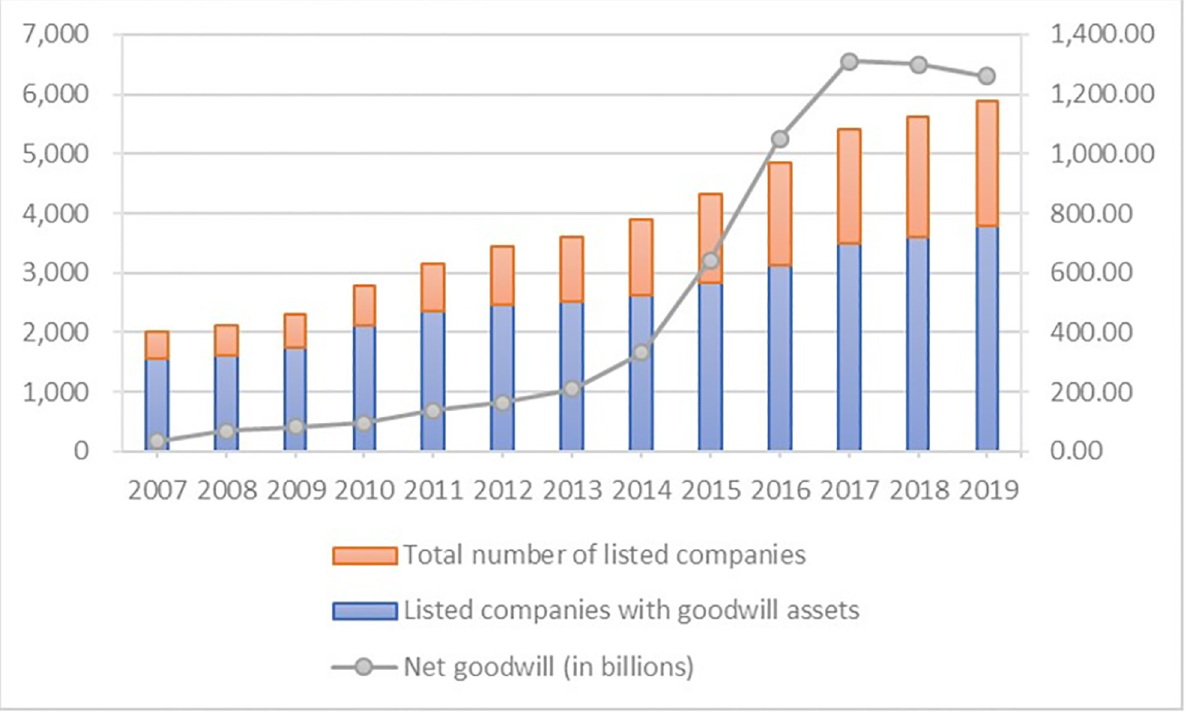
Fig 1. Trend of goodwill of A-share listed corporations in China from 2007 to